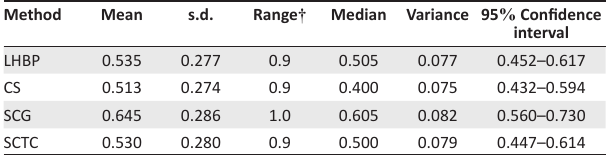
FIGURE 4: Spectrophotometric calibration graph developed at the Quality Control Department of the National Blood Center, Sri Lanka, September 2020 – May TABLE 1: Plasma haemoglobin concentrations (g/dL) of red cell concentrates received at the Quality Control Department of the National Blood Center, Sri